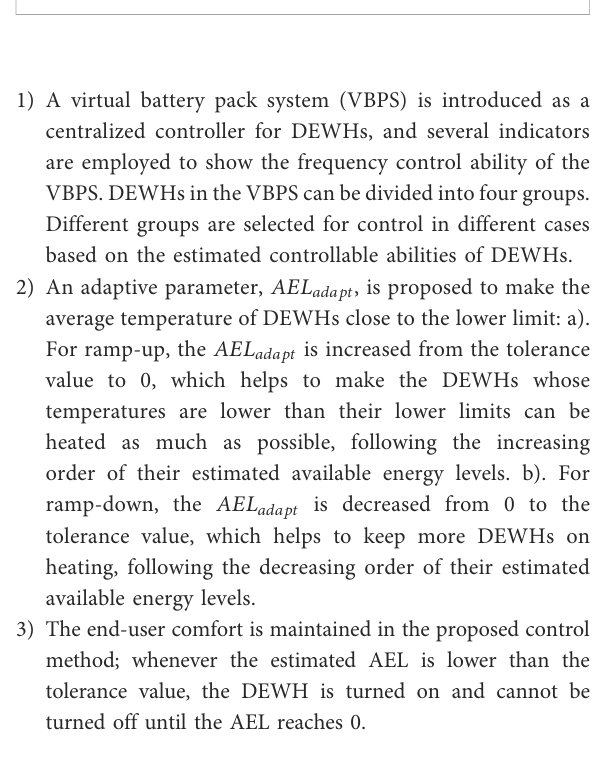
FIGURE 1 Power systems operation states and required